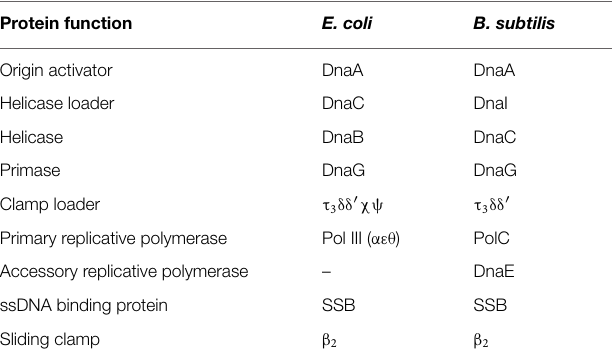
TABLE 1 | A comparison of replication protein nomenclature in E. coli and B. subtilis . Protein